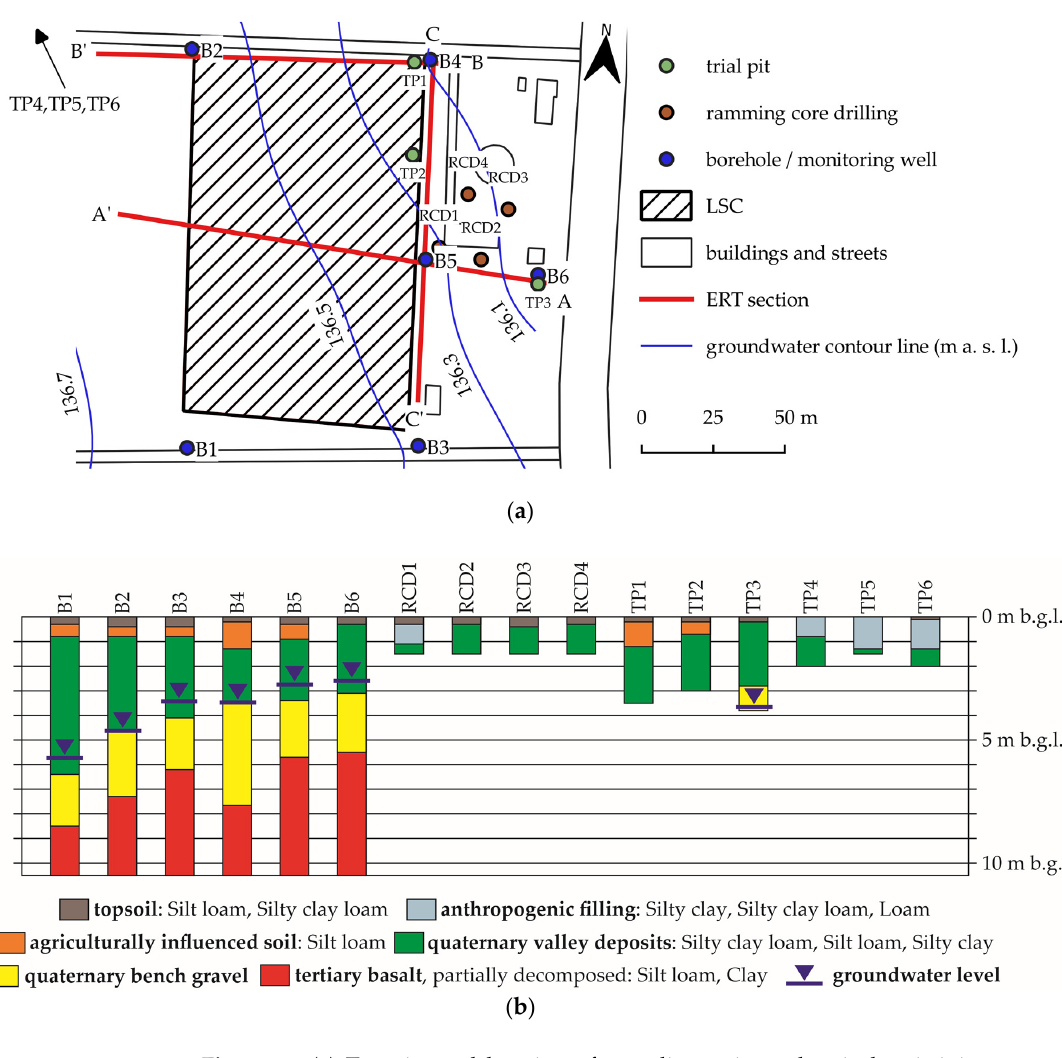
Figure 1. ( a ) Test site and location of sampling points, electrical resistivity tomography (ERT) sections and groundwater contour lines from the groundwater level measurements on 7 April 2021 specified in meters above sea level (m a. s. l.); ( b ) Boreholes (B1–B6), ramming core